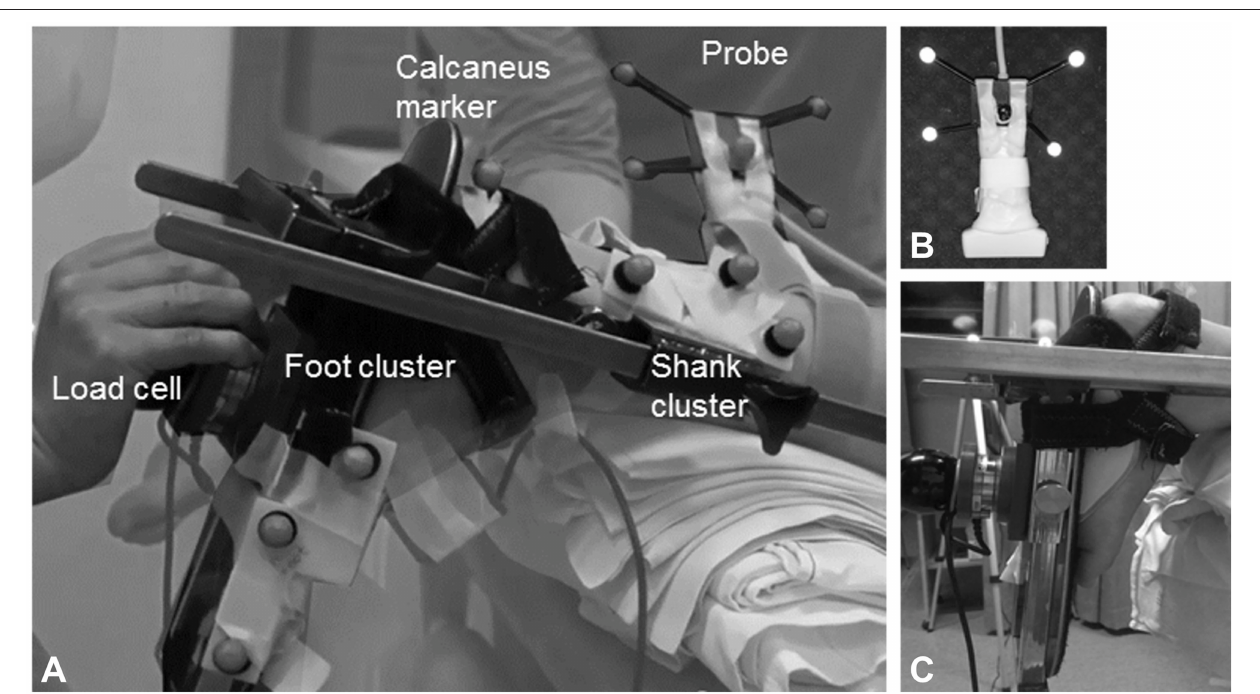
FIGURE 1 | (A) Experimental design of the lower-leg placed in the custom-made orthosis to standardize the knee position and ankle movement; (B) close-up of the ultrasound probe with reflective markers; (C) close-up of the foot attached with an insole to the foot plate of the orthotic. A 6 DoF hand held load-cell was used to measure net ankle joint torque during passive rotation. Two clusters of reflective markers on the tibia and footplate were tracked with motion analysis and used to calculate the foot-plate angle in 3D. The ultrasound probe was placed proximal to the muscle tendon junction, and the position and orientation of the image were defined by motion analysis by means of a cluster of reflective markers attached to the probe. Surface electromyography was collected throughout the experiments from the medial